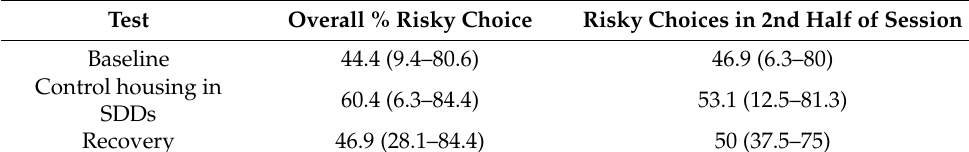
Table 4. Median (minimum–maximum) risk preference in the control condition.